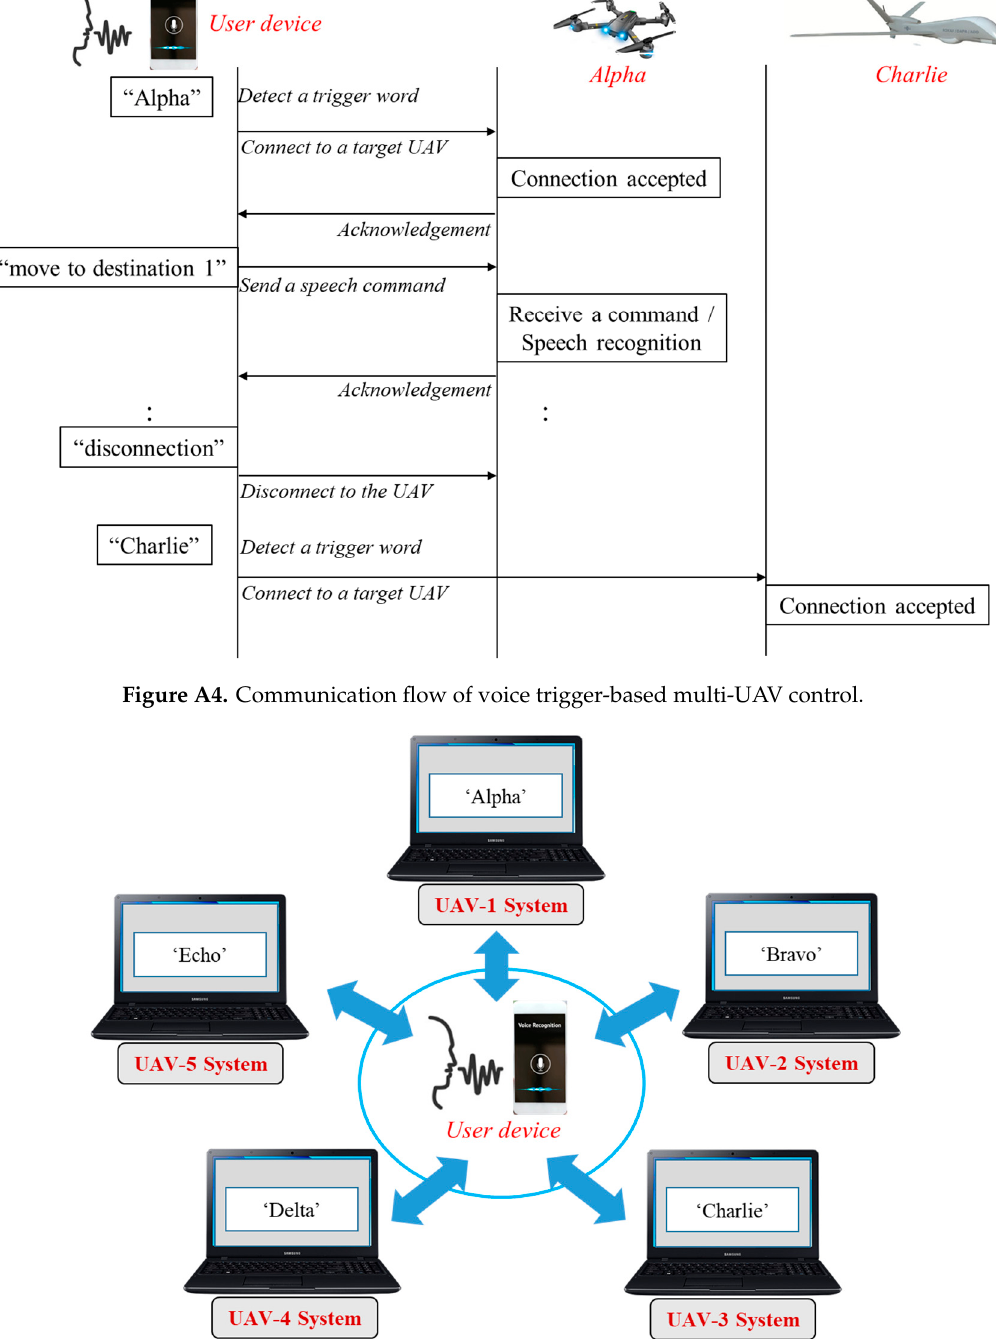
Figure A5. Experimental environments simulating user device and five UAV systems.